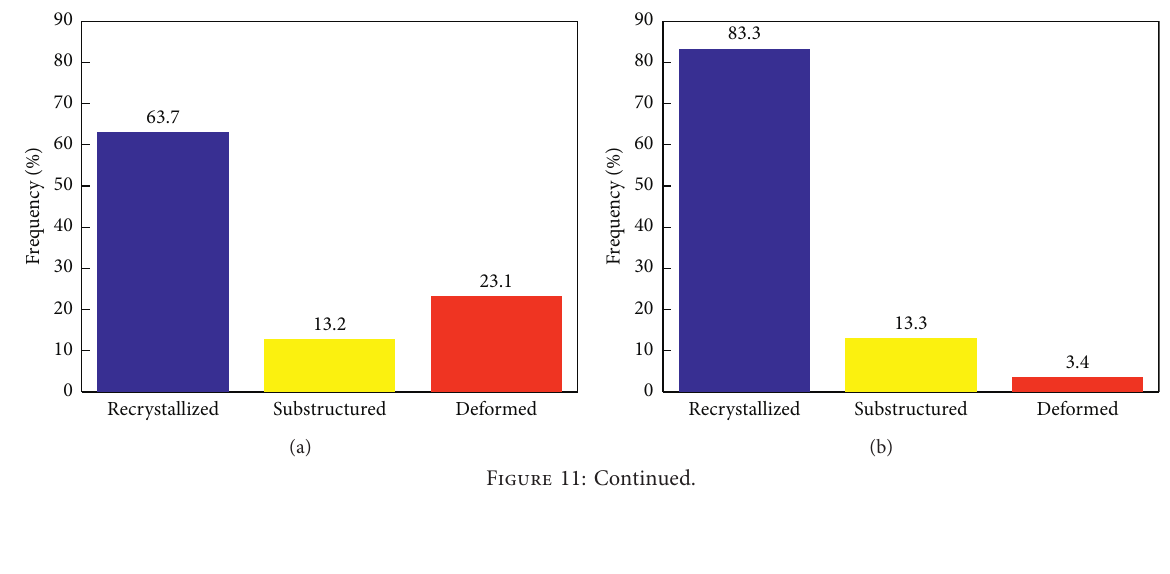
Recrystallized Substructured